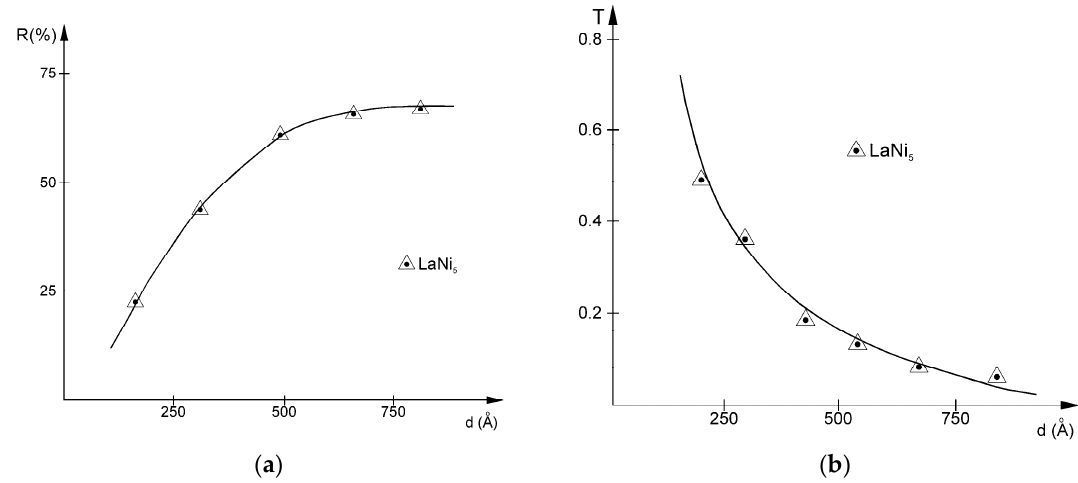
Figure 5. Film thickness dependence of ( a ) absolute differential optical reflectance and ( b ) transmittance for λ HeNe = 632.8 nm